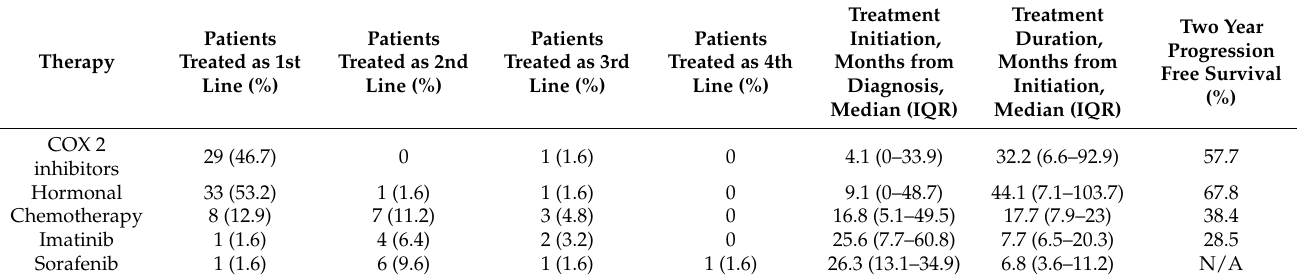
Table 3. Prevalence, duration, and outcome of the different treatment modalities.